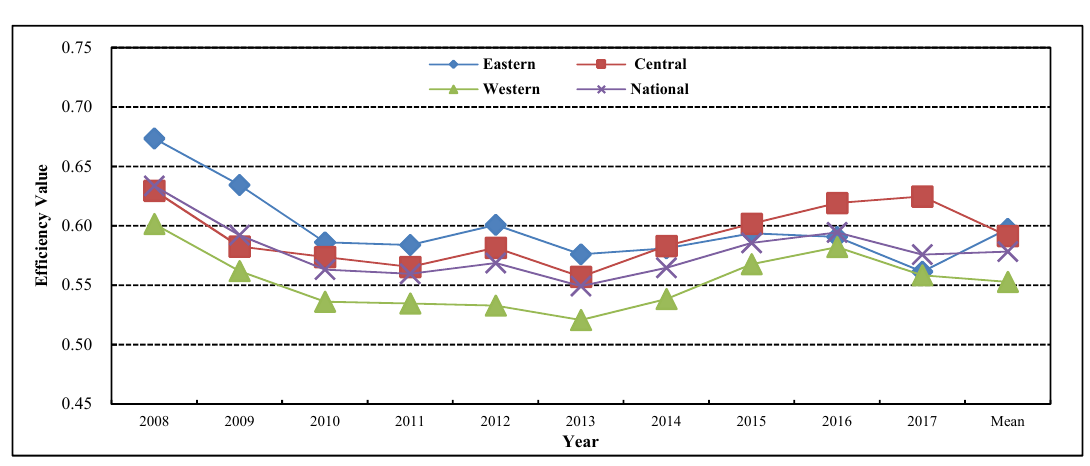
Figure 3. Allocation efficiency of rural public health resources in China and its Eastern, Central and Western regions from 2008 to 2017.